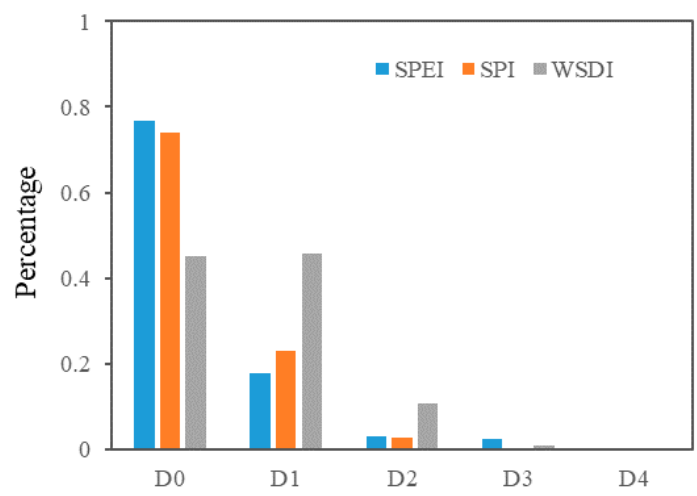
Figure 12. Percentage of meteorological stations (SPEI, SPI) or area (WSDI) of Mongolia experiencing di ff erent drought severity levels from 2002 to 2017.